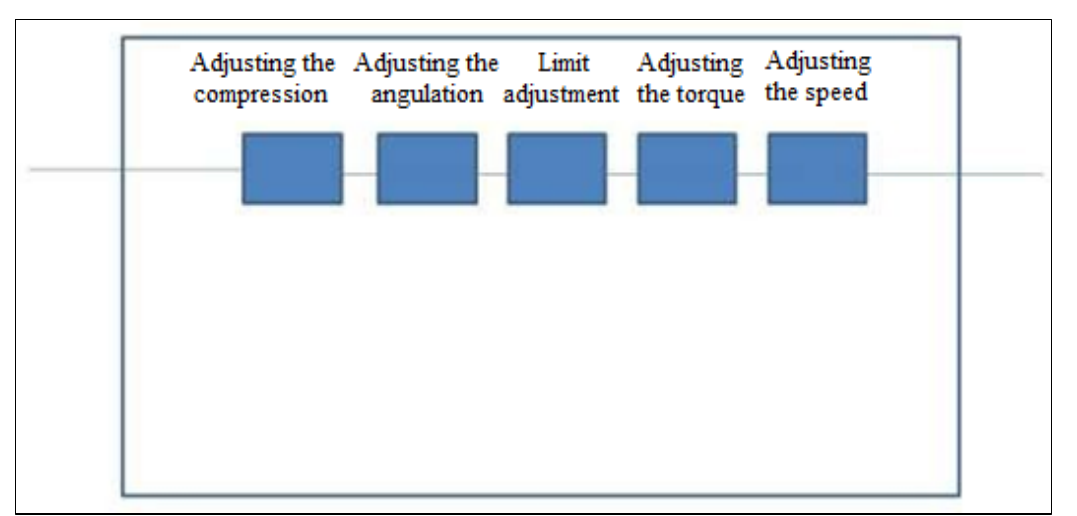
Figure 3: Current